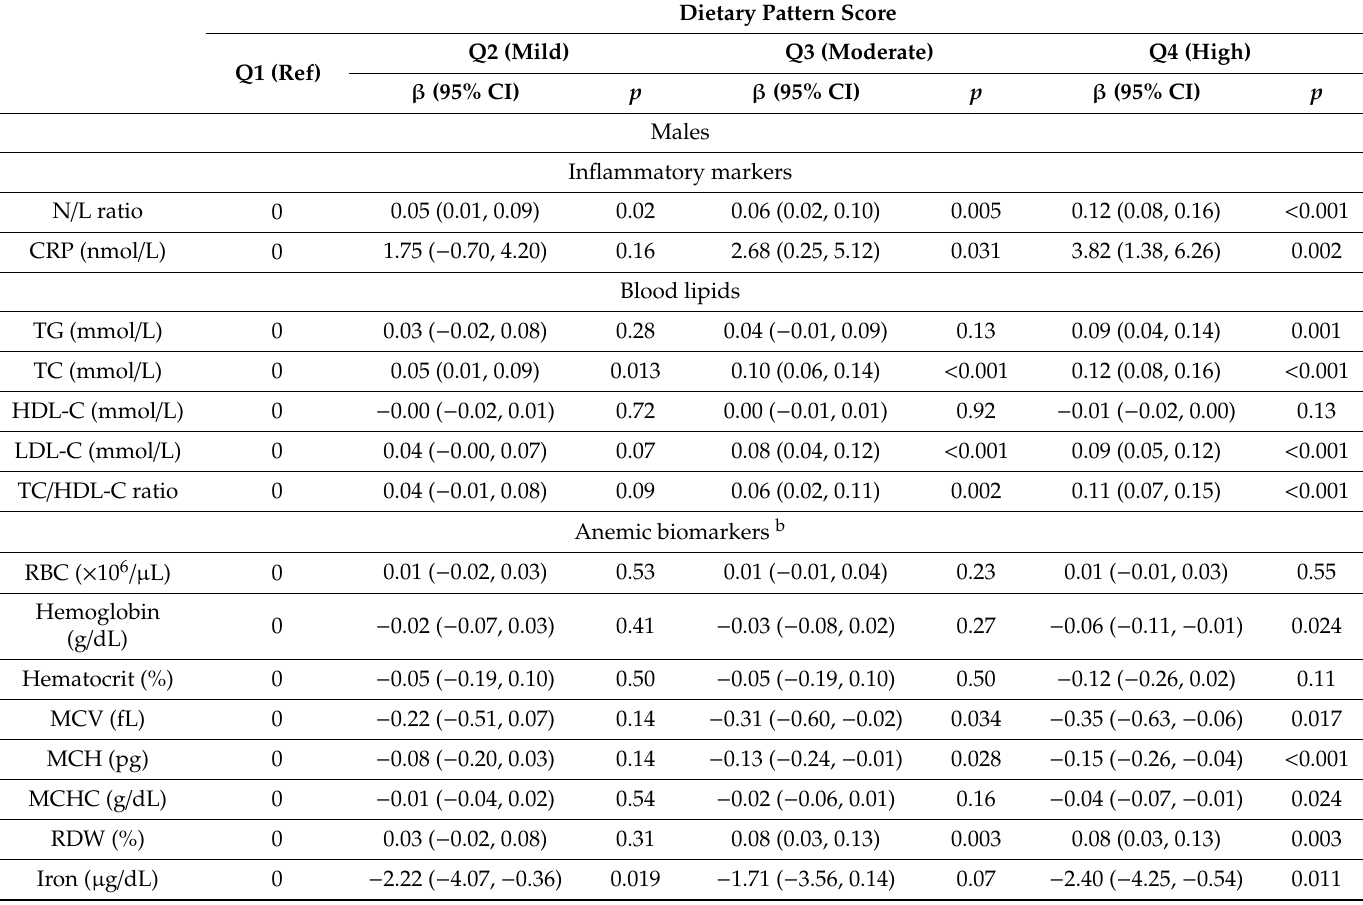
Table 4. Linear association of quartiles of inflammatory dietary pattern scores with inflammatory markers, lipid profiles, anemic biomarkers, and kidney function biomarkers a